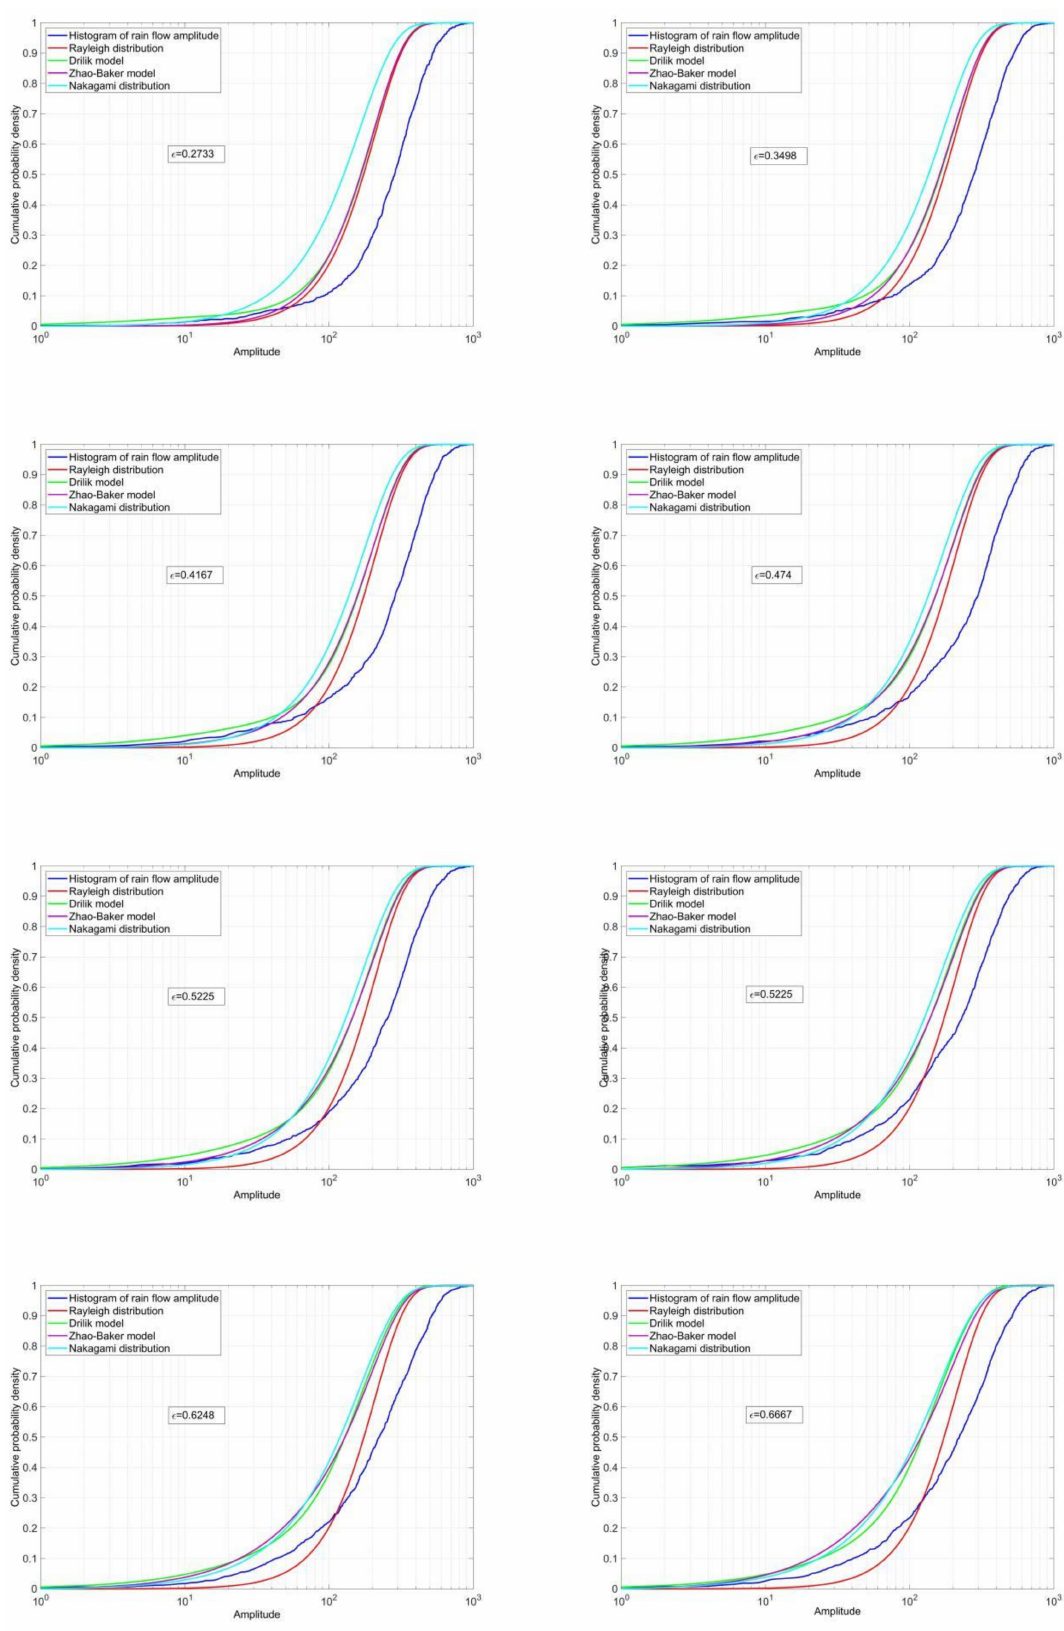
Figure A8. Rain flow amplitude CDF (band-limited white noise